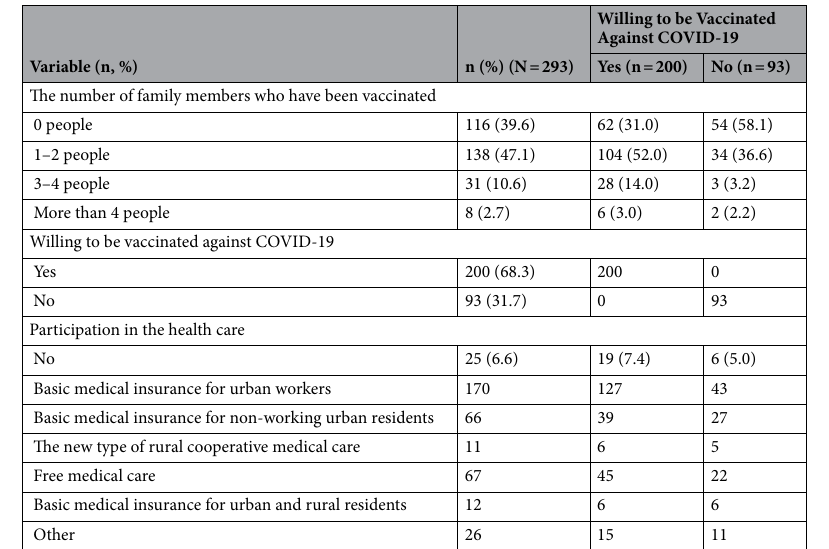
Table 1. Demographic characteristics of participants in this study.